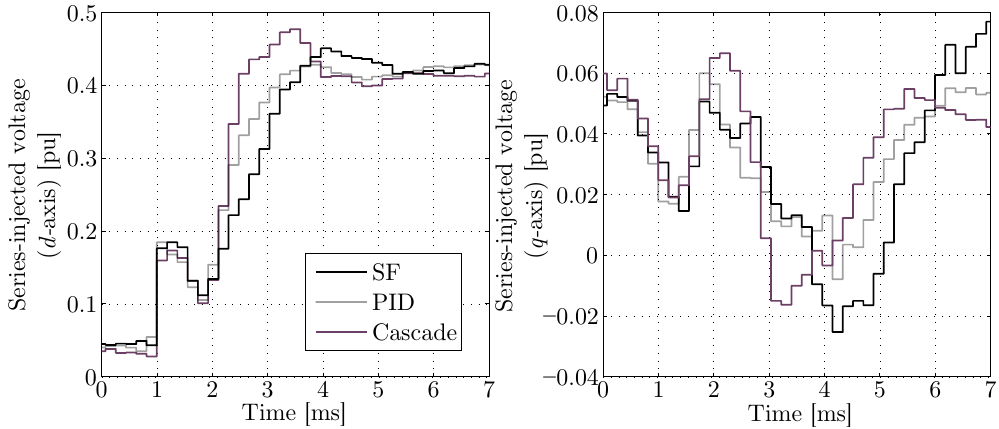
Figure 23. Experimental results. dq -axis components of the series-injected voltage for the PID, the cascade, and the SF controllers when the load is connected. ( left ) d - and ( right ) q -axis